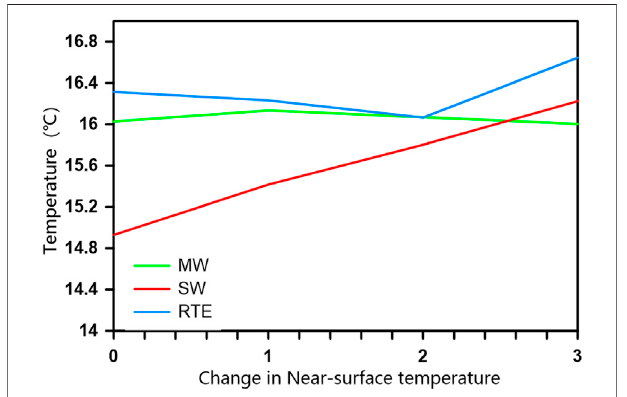
FIGURE 7 | Comparison of experimental results and actual measurement data in